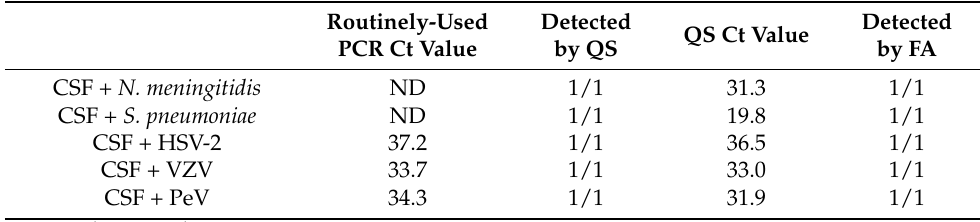
Table 5. Clinical CSF samples results with QS and